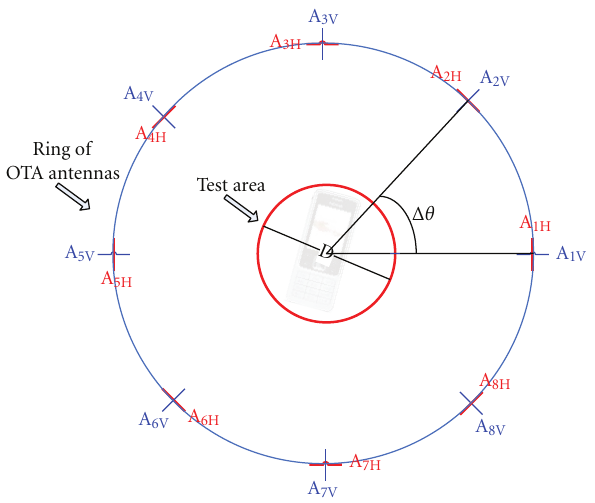
Figure 3: Ring of OTA antennas and the test zone.